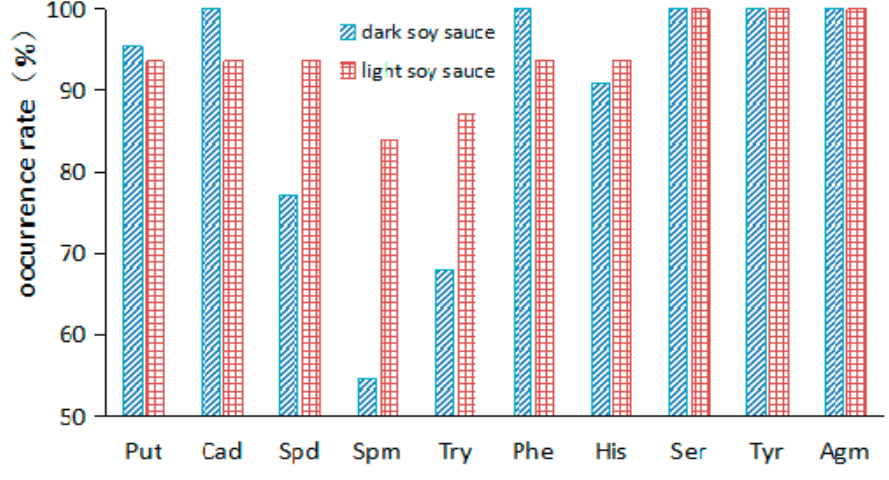
Figure 2. Occurrence of BAs in two kinds of soy sauces.